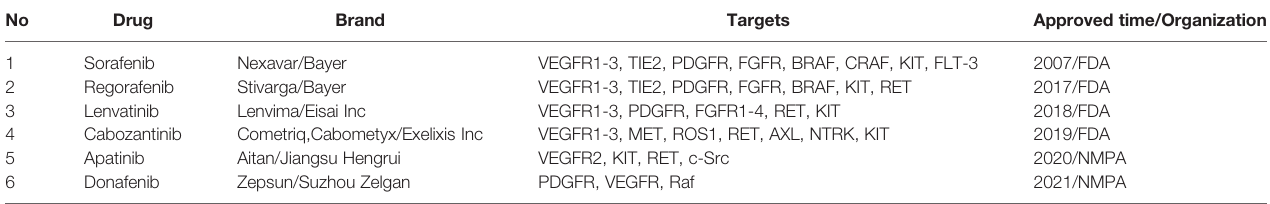
TABLE 1 | Summary of approved TKIs. No Drug